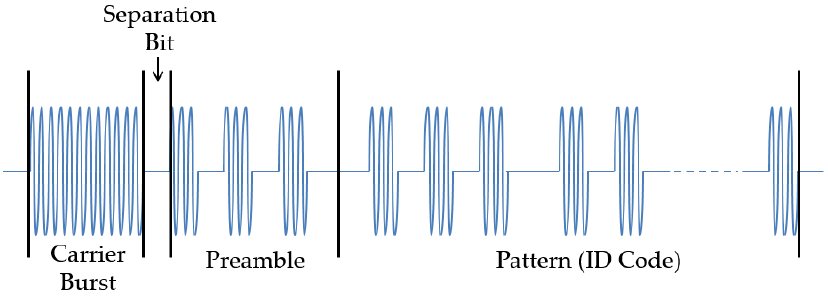
Figure 7. AMS AS3933 wake-up signal format.